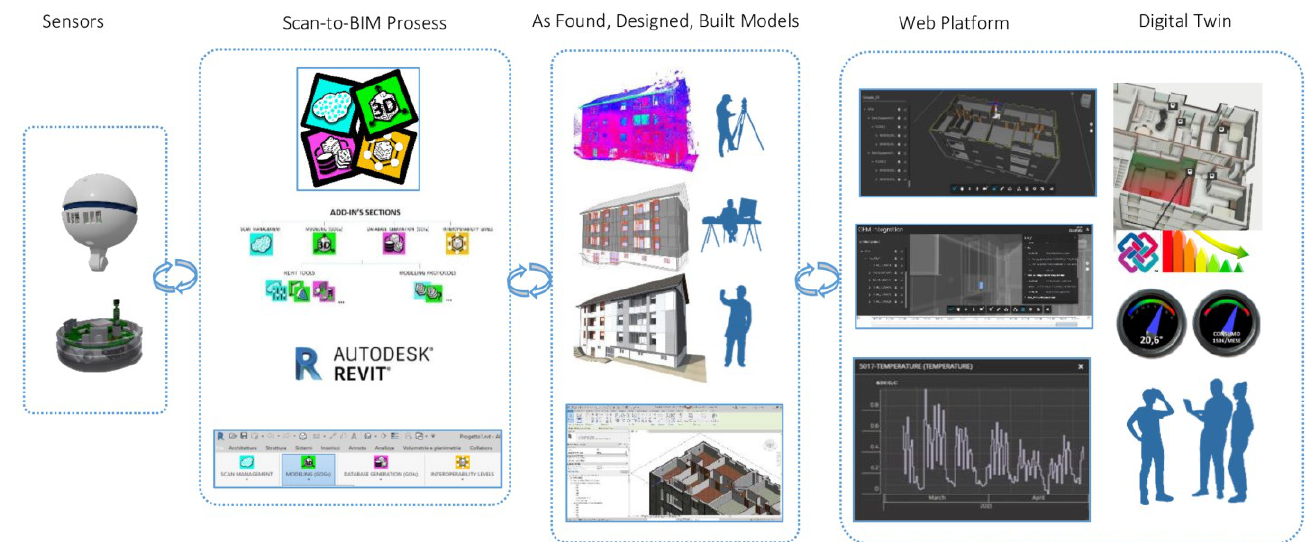
Figure 15. The HOMeBIM live app process development: from real-time data to a web platform and digital twin.